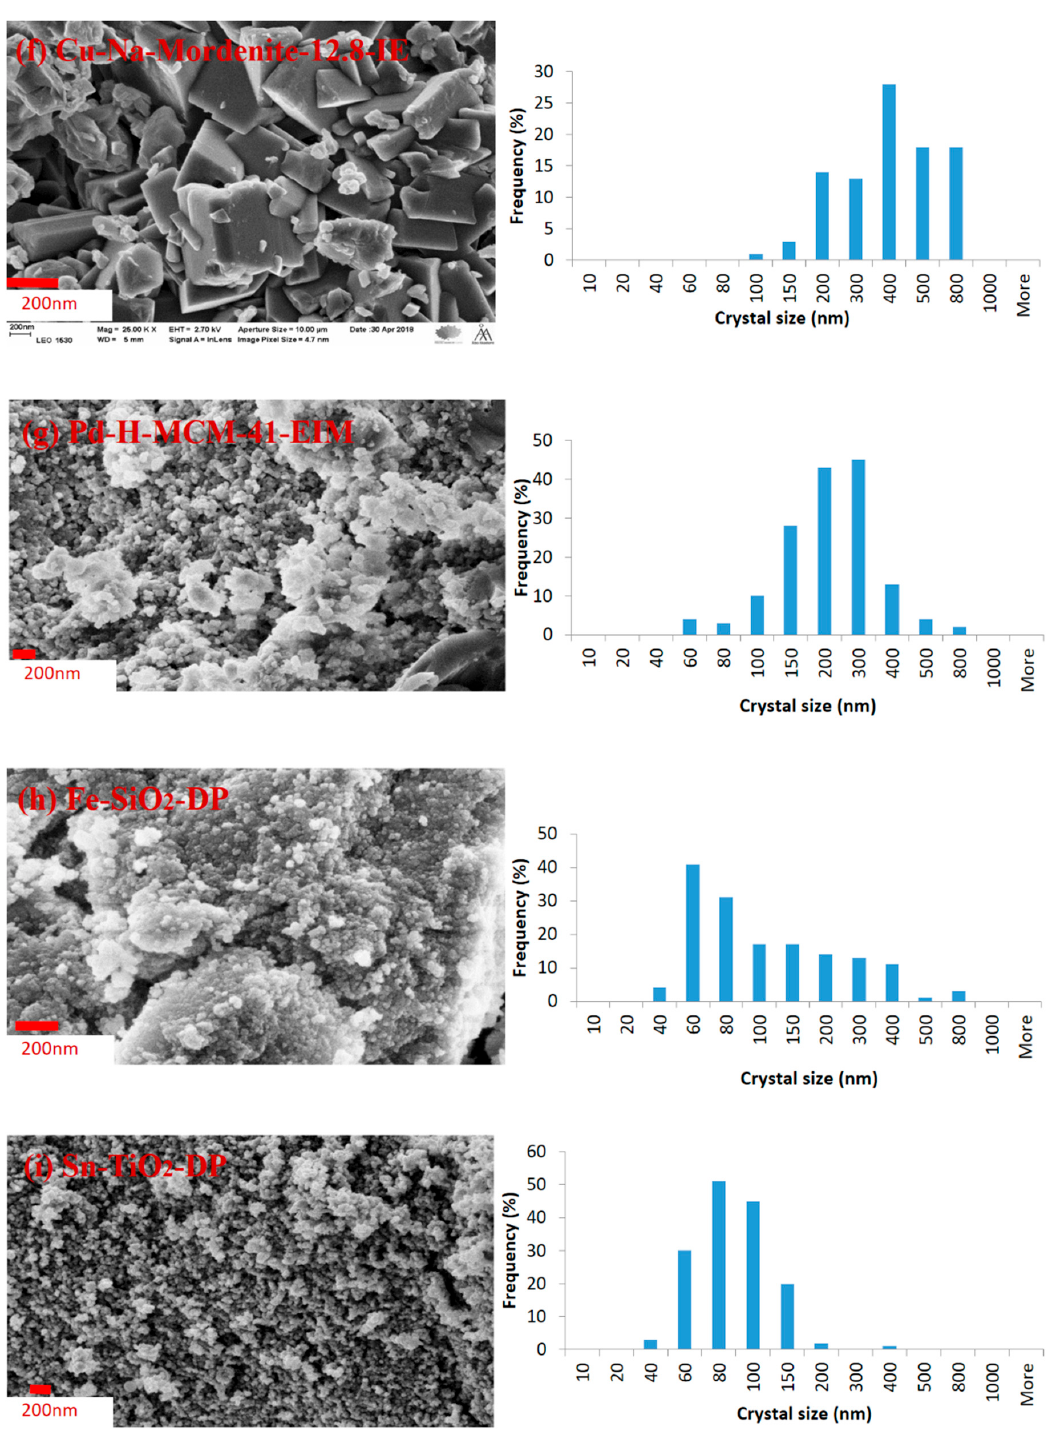
Figure 2. Scanning electron micrographs and crystal size distribution histograms of ( a ) Cu-H-Beta-25- IE, ( b ) Cu-H-Beta-150-IE, ( c ) Cu-H-Beta-300-IE, ( d ) Cu-H-Beta-150-EIM, ( e ) Cu-H-Beta-150-DP, ( f ) Cu- Na-Modernite-12.8-IE, ( g ) Pd-H-MCM-41-EIM, ( h ) Fe-SiO 2 -DP, and ( i ) Ni-H-Beta-25-EIM catalysts.